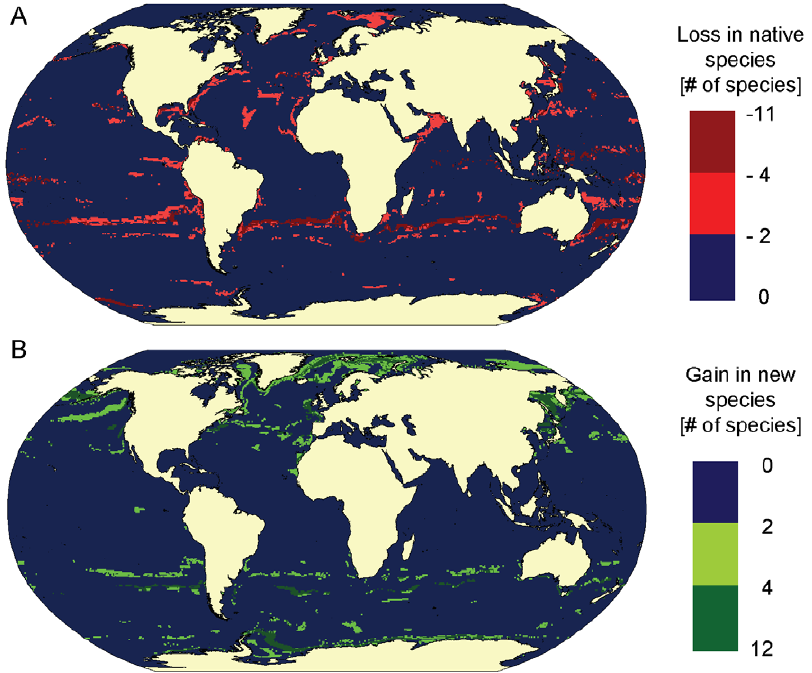
Figure 5. Projected effects of climate change on marine mammal species richness. Projected changes in overlap of optimal habitat across all species from 1990–1999 to 2040–2049 using the IPCC-A1B climate change scenario (0.5 u 6 0.5 u grid cells) A. Loss in number of native species, B. Gain in number of new species. Biodiversity changes are expressed relative to species richness predicted for the 1990s, and assuming a presence threshold of RES . 0.6.